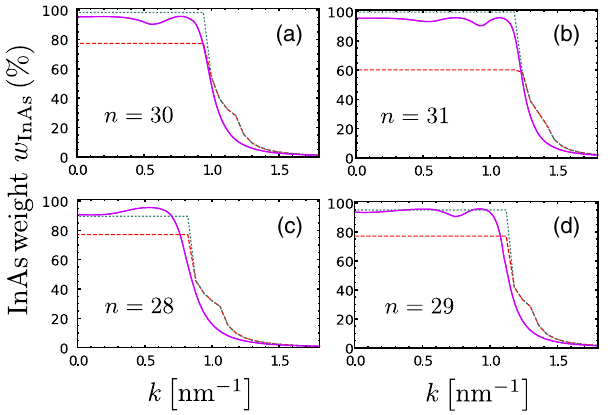
for L 1 ¼ 5 nm ( L 1 ¼ 4 . 75 nm) and Φ ¼ 0 . 1 eV. Solid purple line: Weights obtained numerically using the self-consistent Schrödinger-Poisson method for L 2 ¼ 100 nm. Dashed red line: Weights obtained within the square-well model using L 0 2 ¼ 16 nm. Dotted green line: Weights obtained using the extended square-well model which assumes an energy-dependent L 0 2 for bands above the Fermi level. Here we have used L 0 2 ¼ 91 . 6 nm) for the left (right) panels. In both cases, 40 . 8 nm ( L 0 2 ¼ the extended analytical model yields a significantly improved agreement with the Schrödinger-Poisson